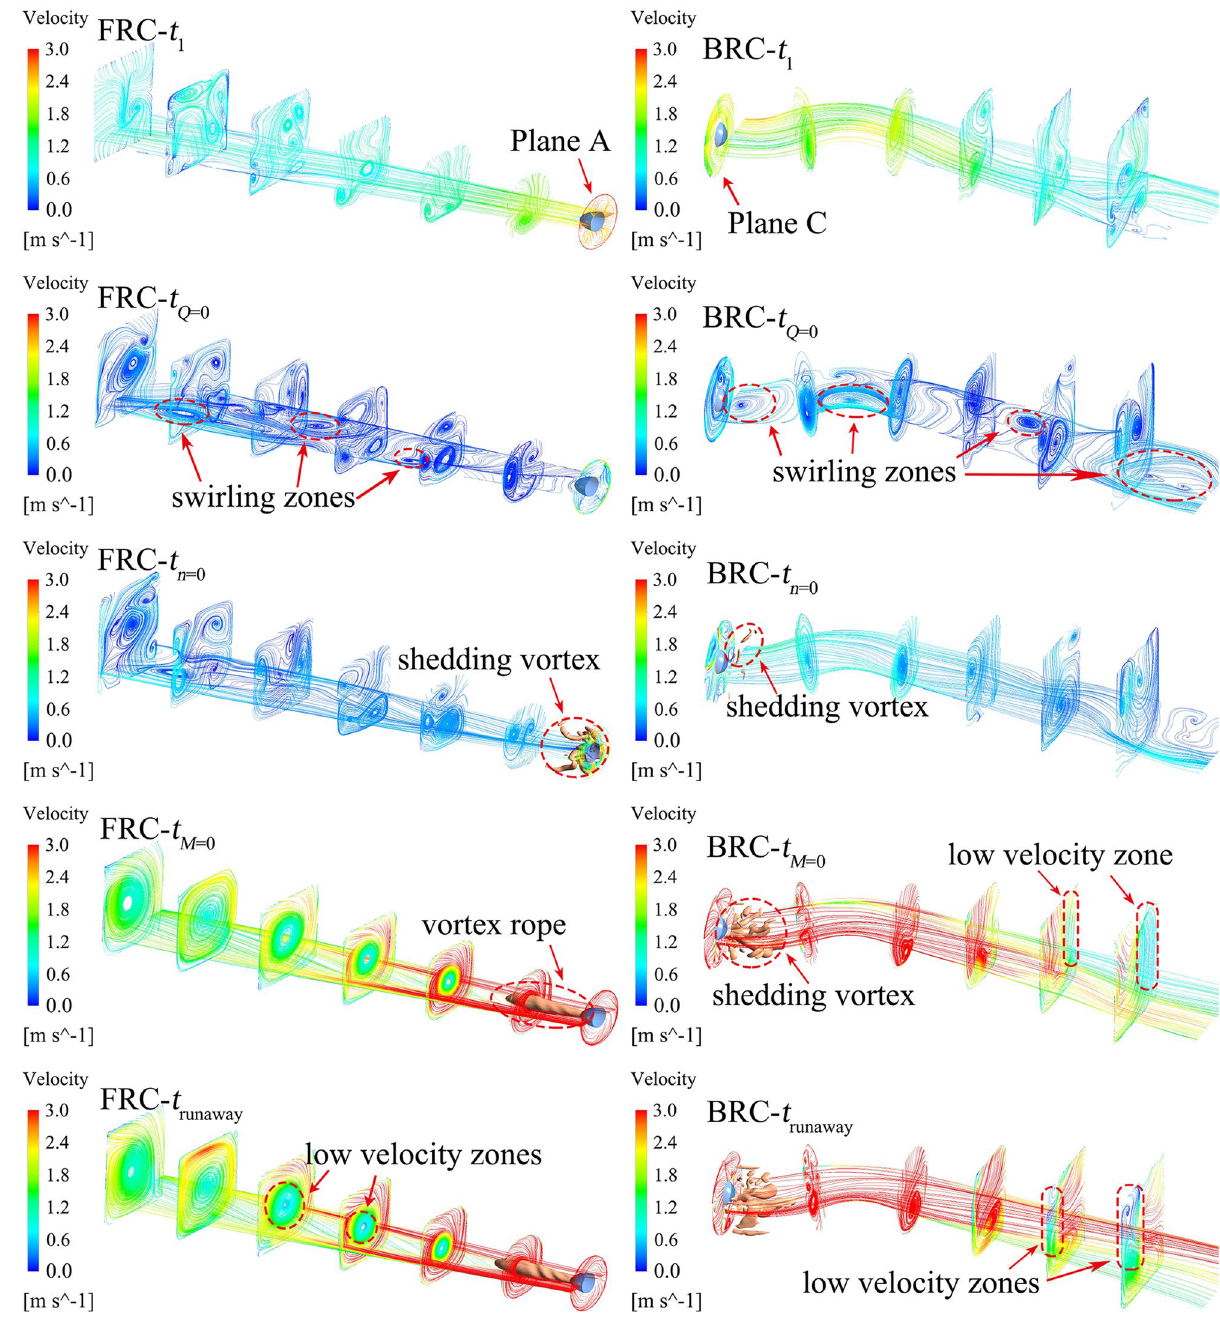
Figure 19. Streamline and vortex core distribution of inlet conduit under FRC and